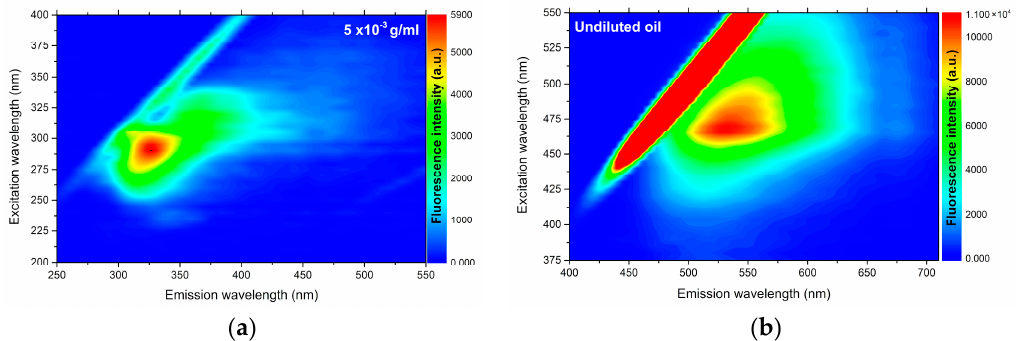
Figure 2. Excitation–emission map of Caryocar brasiliense oil obtained by exciting between 200 and 400 nm and in the emission 250 and 600 nm range. ( a ) Caryocar brasiliense oil at 5 × 10 − 3 g mL − 1 concentration; ( b ) Undiluted Caryocar brasiliense oil.